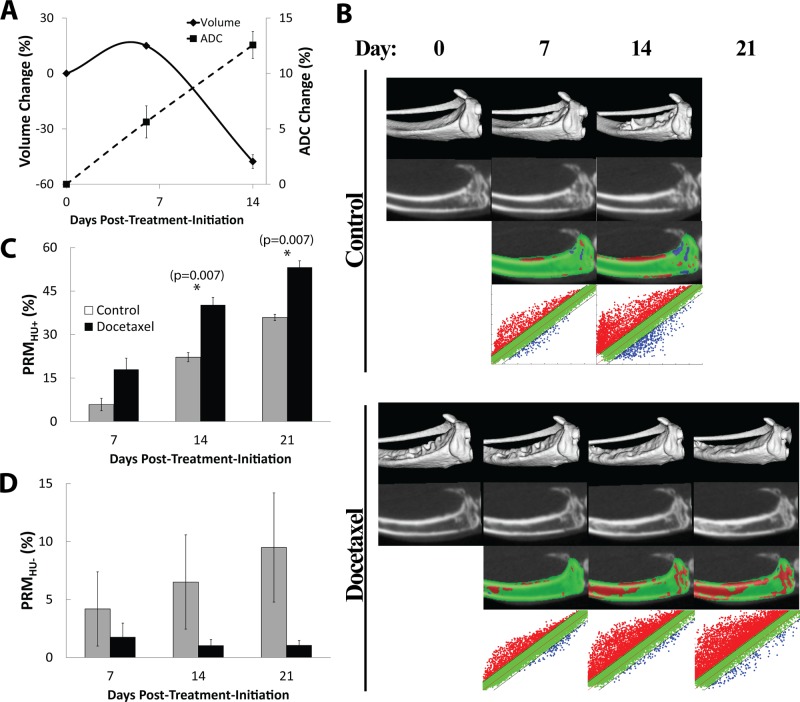
LAPC-9 tumors show slower mixed PRMHU+/- response with docetaxel treatment compared to PC3.(A) Time plots of tumor volume (solid line) and ADC (dashed line) show successful response to treatment (n = 3) as volume shrinkage and ADC increase. (B) PRMHU+ bar plot over time shows more bone density increase in the docetaxel-treated group compared to controls (n = 3), significant on days 14 and 21. (C) PRMHU- bar plot over time shows very little bone loss in the treated group compared to elevated bone mineral loss in the controls (though not significant in this study). (D) Representative images for a control (top) and docetaxel-treated (bottom) mouse showing (from top to bottom) an isosurface, CT slice, PRM overlay, and PRM scatterplot from pre-treatment to 21 days post-treatment.